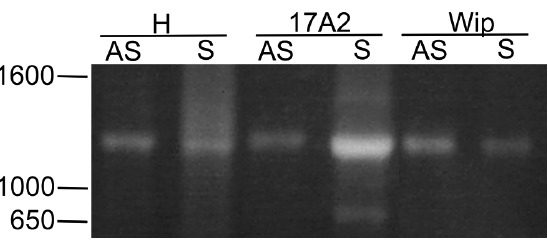
Fig. 5 – Agarose gel electrophoresis of sense and antisense P element fragments obtained by RT-PCR of embryos of D. melanogaster (H) and D. willistoni (17A2 and Wip). The sense cDNA was synthesized starting from the meli1+ sense primer and the antisense cDNA was synthesized starting from mele3- antisense primer. The first cDNA amplification was done with meli1+ and mele3- primers and the re- amplification reaction with meli2+ and mele3- primers. (AS) Anti- sense fragments. (S) Sense fragments. A 1-kb DNA ladder is shown on the